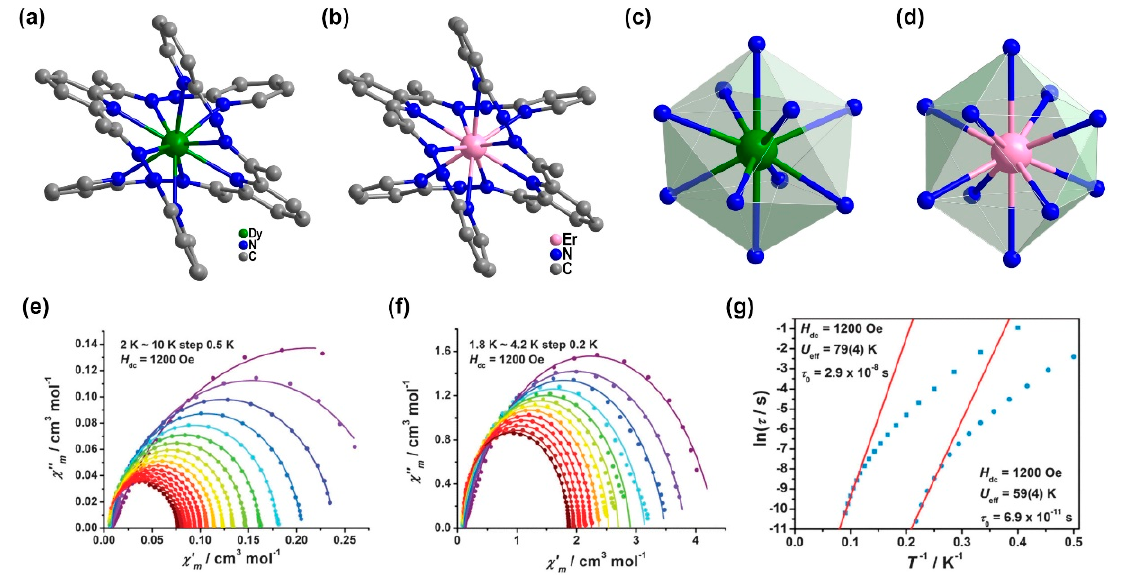
Figure 8. ( a , b ) Molecular structures of the cationic part of 8 and 9 , ( c , d ) coordination geometry of the Ln(III) ions, ( e , f ) Cole–Cole plots for 8 and 9 obtained from the AC susceptibility data (external DC field 1200 Oe). The solid lines correspond to the best fit obtained from the generalized Debye equation, and ( g ) Temperature-dependence of relaxation time (the red solid lines represent the Arrhenius law fit). Figures and captions are reproduced from Reference [41] with permission from the Royal Society of Chemistry.